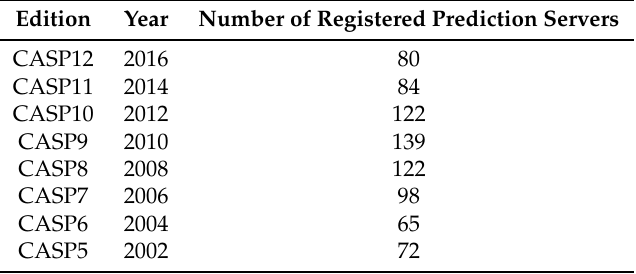
Table 1. Number of participant servers in the Critical Assessment of Protein Structure Prediction (CASP) in the last 8